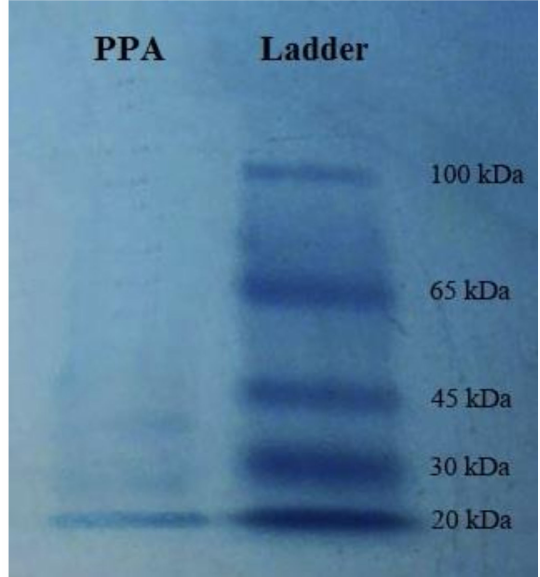
Figure 1. Molecular weight of the purified lectin from Polygonum persicaria (PPA) on SDS– polyacrylamide gel electrophoresis.